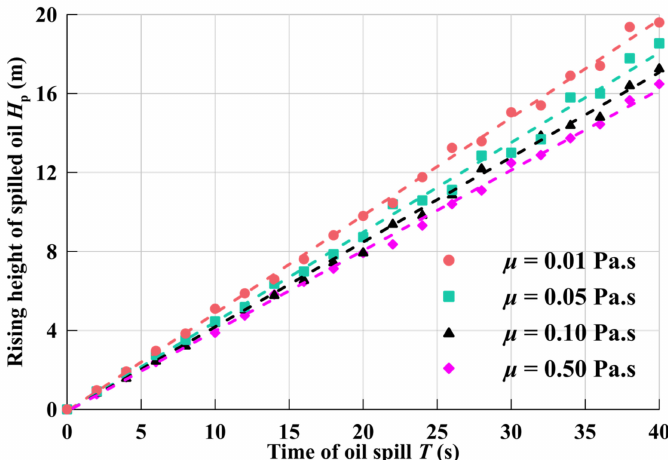
Figure 12. Rising height of spilled oil for three different oil viscosities.